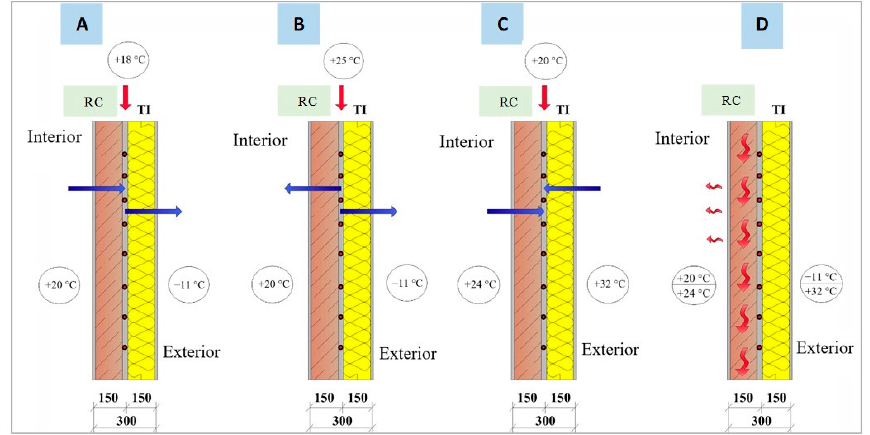
Figure 18. The multiple ‐ function character of active thermal protection—ATP (WATER base) [23], RC—reinforced concrete, TI—thermal insulation, A—Thermal barrier, B—Heating, C—Cooling, D—Heat/cold accumulation.